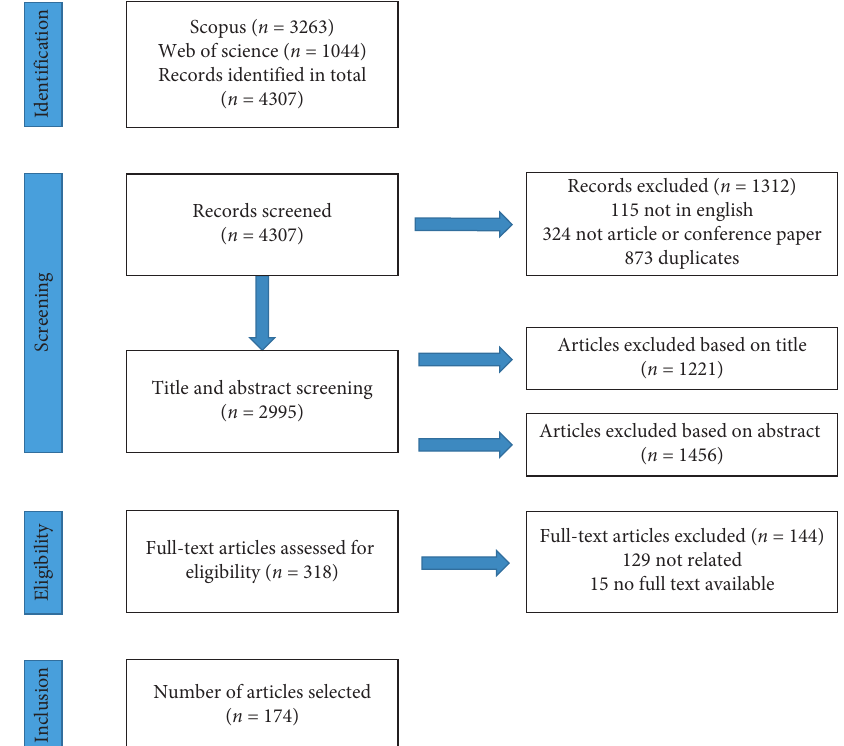
Figure 1: Overall flow of the review process and strategy.